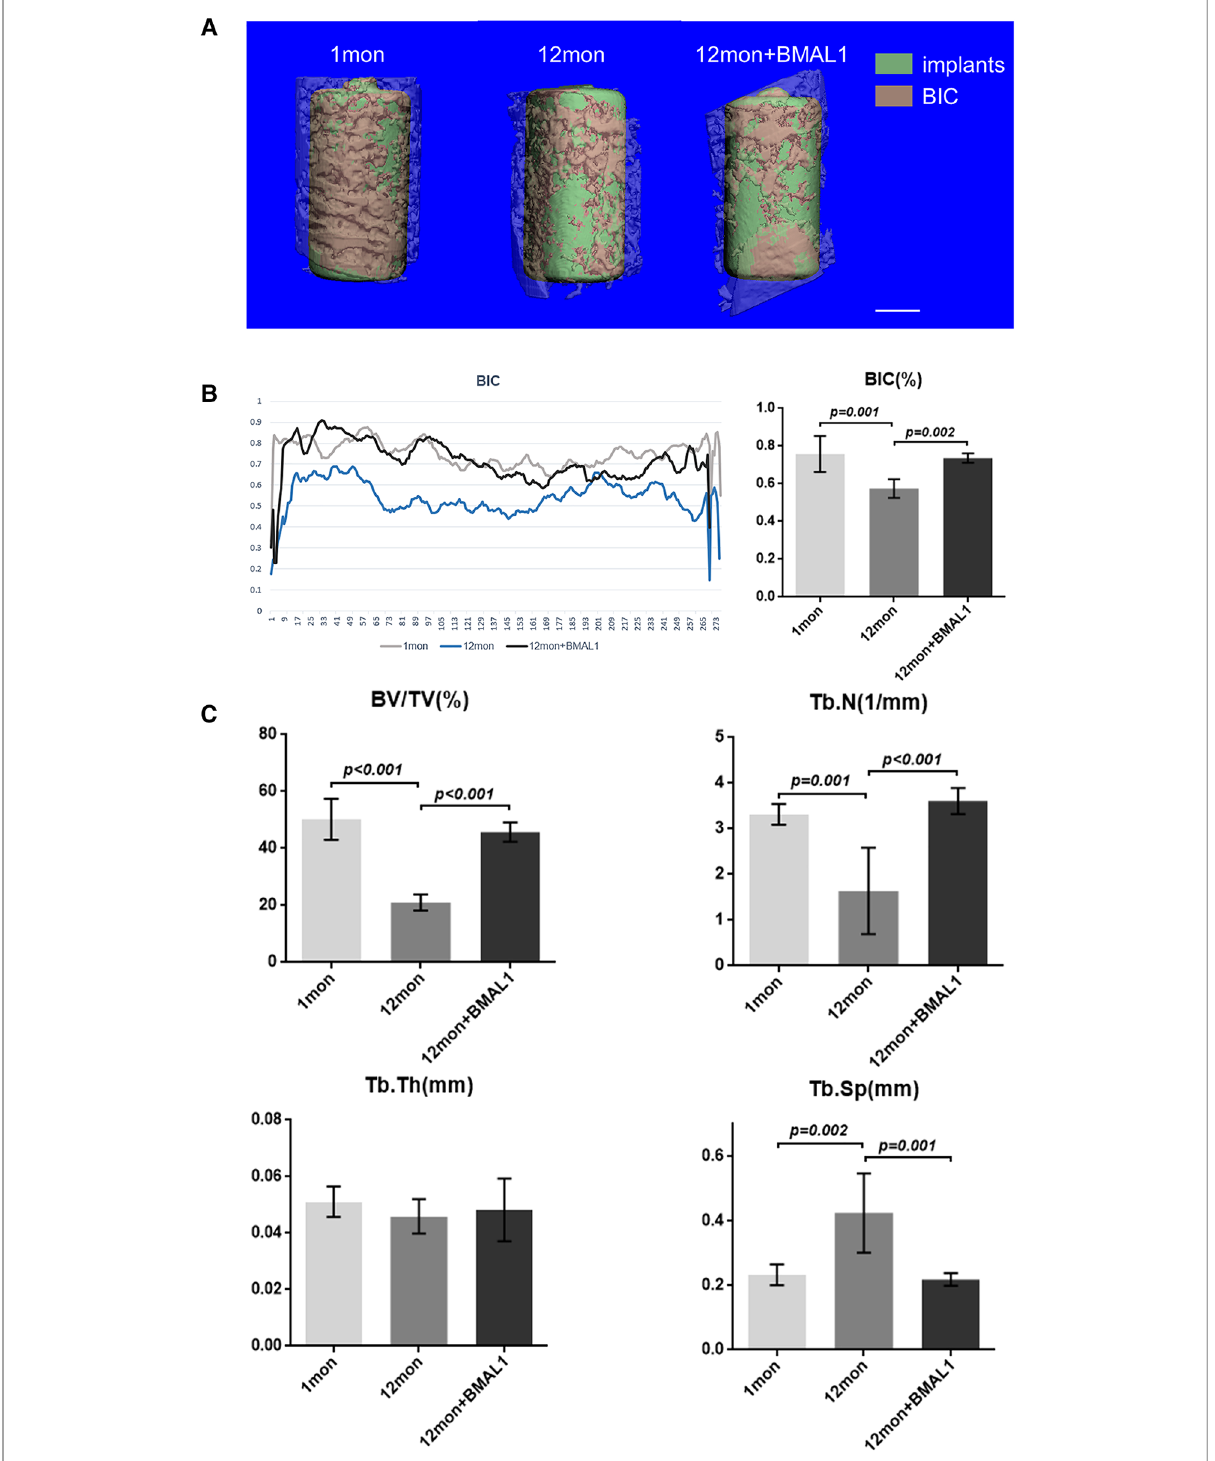
FIGURE 4 Micro-CT analyses of BIC and trabecular bone of femurs. ( A ) Representative 3D reconstruction images of peri-implant sites. Scale bar=500 µm. ( B ) Representative liner graph and quantitative analyses of BIC rate. ( n =4) ( C ) Quantitative analyses of bone morphology parameters regarding BV/TV (%), Tb. N (1/mm), Tb. Th (mm), and Tb. Sp (mm). ( n =4). BIC, bone-to-implant contact; BV/TV, bone volume fraction; Tb. N, trabecular number; Tb. Sp, trabecular